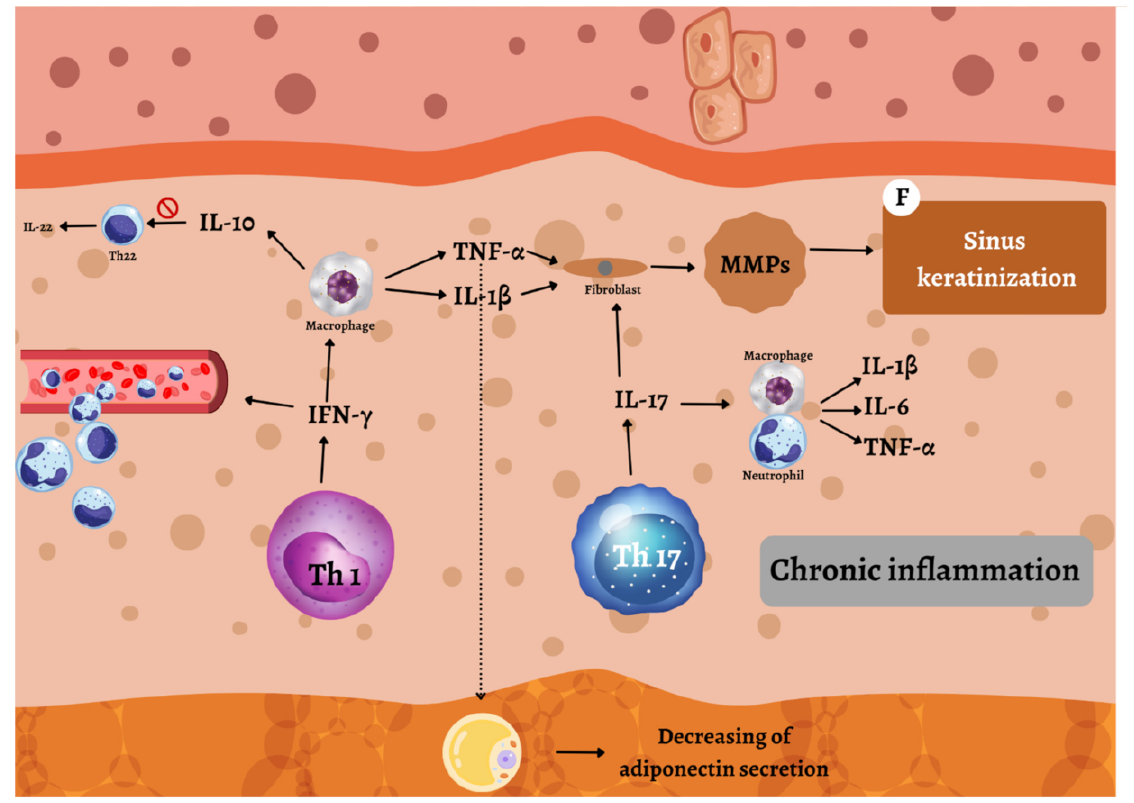
Figure 3. The third event in HS pathogenesis is chronic inflammation with sinus tract formation. Th1 cells produce IFN- γ , which recruits more inflammatory cells. Macrophages, activated dendritic cells, and T lymphocytes produce TNF- α , which has a multifactorial role. TNF- α supports Th17 polarization, suppresses adiponectin secretion, and induces the production of MMPs. Th17 cells produce IL-17 which stimulates neutrophils and macrophages to produce IL-1 β , IL-6, TNF- α , and MMPs. TNF- α , IL-17, and IL-1 β induce fibroblasts to produce MMPs, which lead to fibrosis and sinus tract formation